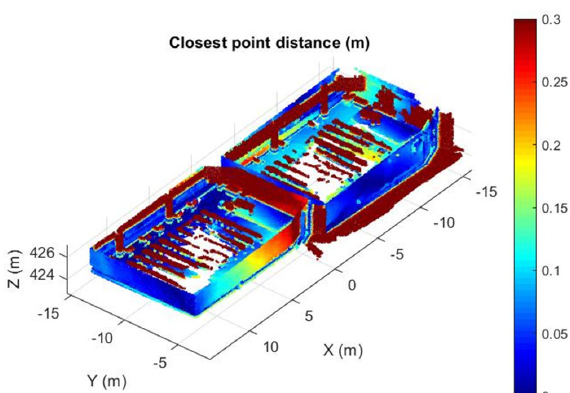
Figure 8 . Closest point distances between the iPad Pro and the 3D model. The ceiling has been deleted for improving indoor visualization.